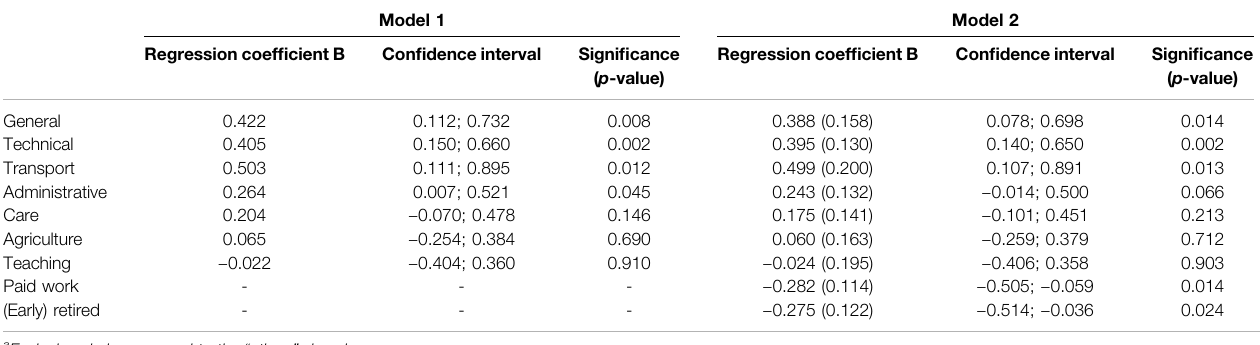
TABLE 3 | Linear regression models of LRPD on occupational domain 1 , adjusted for age (model 1), and adjusted for age and work status (model 2). Source: Longitudinal Aging Study Amsterdam ( N (cid:1)